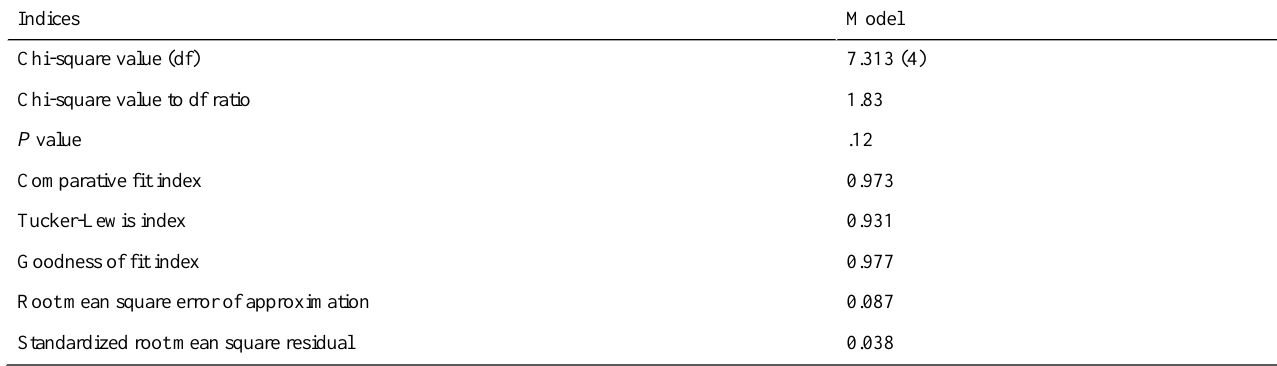
Table 4. Fit indices for confirmatory factor analysis model.